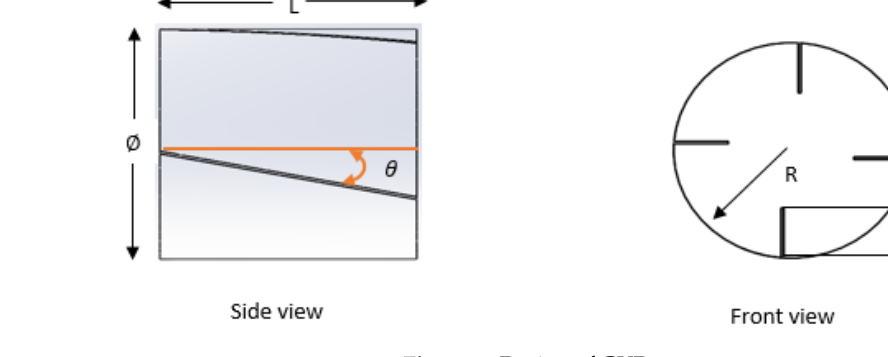
Figure 4. Installation of guide vane design (GVD) at the intake manifold.